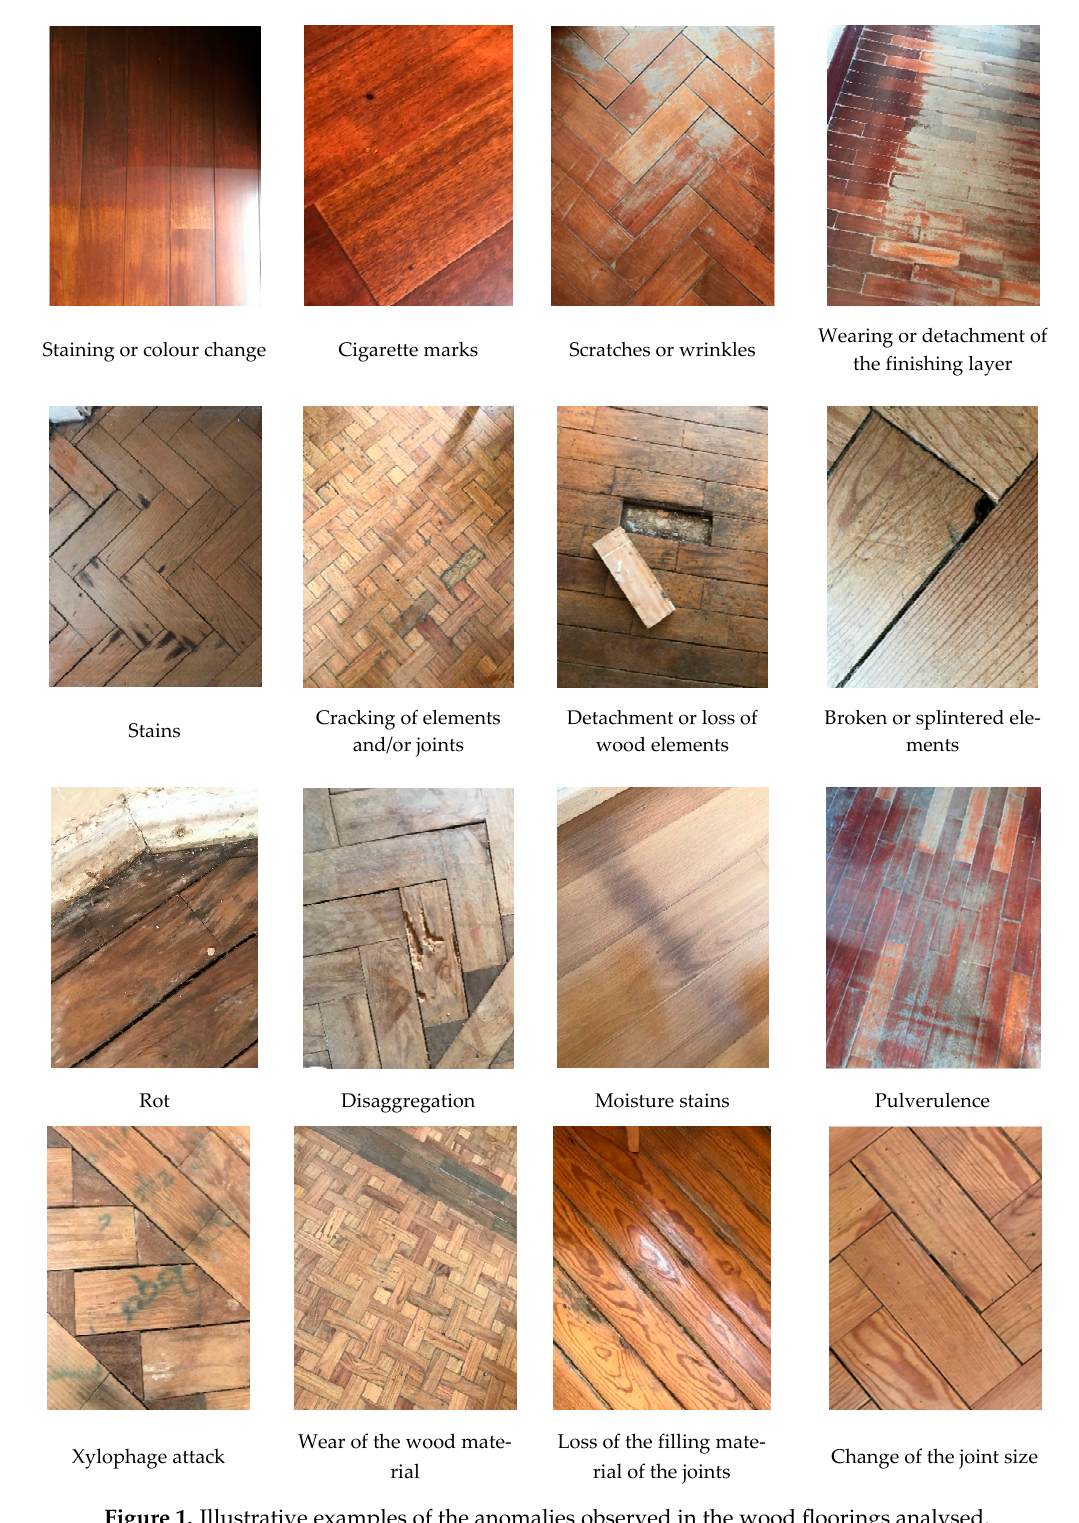
Figure 1. Illustrative examples of the anomalies observed in the wood floorings analysed. Table 1. Degradation levels of aesthetic anomalies.